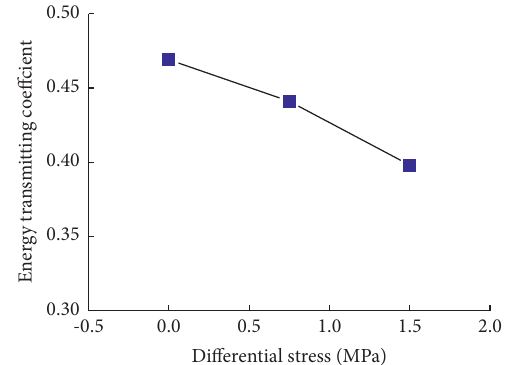
Figure 12: Energy transmitting coefficients of stress wave in the intact rock under different differential